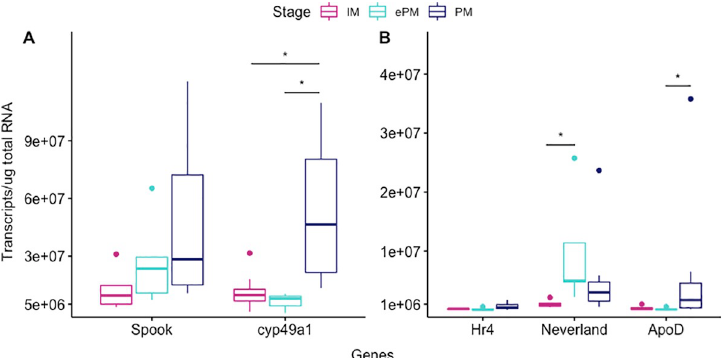
Fig 7. Boxplot representation of the candidate gene expressions in the YO of intact C . sapidus at different molt stages. Gene expression was measured by absolute qPCR assays and expressed in the number of transcripts/ μ g total RNA. Molt stages are colored as followed: IM (dark pink), ePM (turquoise), and PM (dark blue). (A) Expression of Spook and probable cytochrome p450 49a1(cyp49a1) . (B) Expression of Hormone receptor 4 (Hr4) , Neverland , and Apoprotein D-like (ApoD) . The expression levels measured at the three molt stages were analyzed using a non- parametric one-way ANOVA Kruskal-Wallis followed by a Dunn post hoc test. Statistical differences were noted as” � ” P < 0.05. The dots represented outliers in the